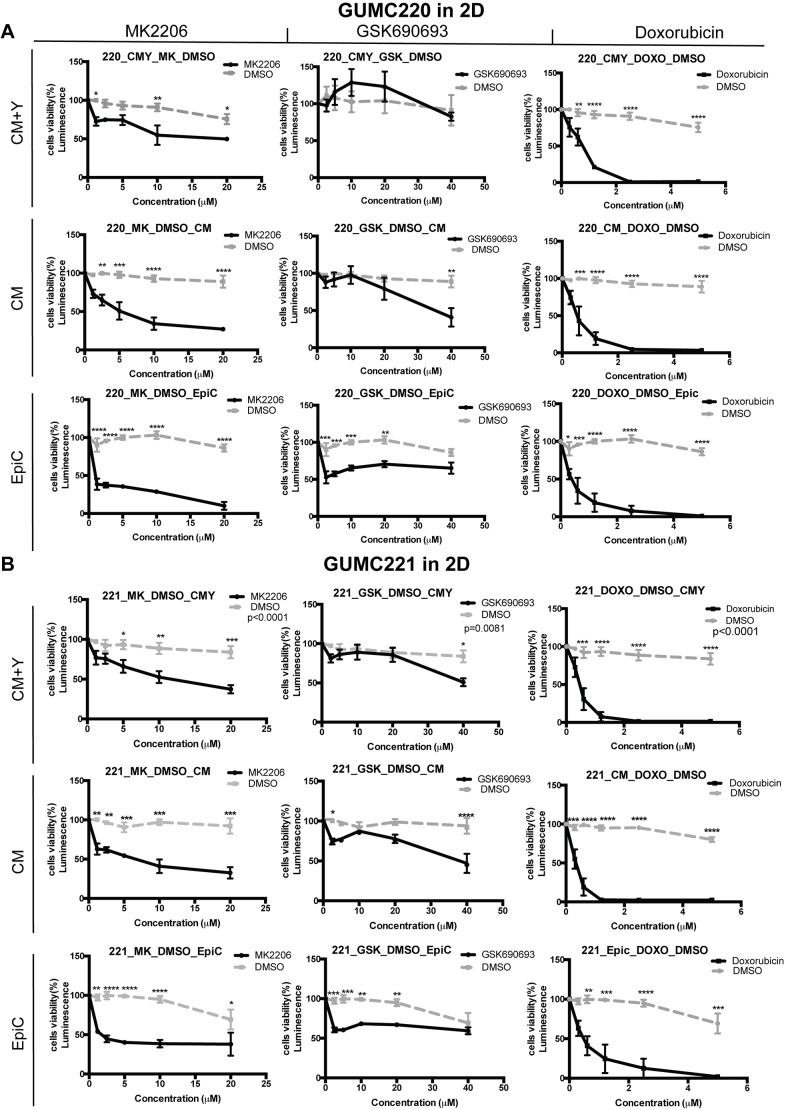
Viability of GUMC220/221 2D cell cultures exposed to MK2206, GSK690639 and doxorubicin in CM+Y, CM and EpiC media. (A,B) Cell viability measured after 3 days for GUMC220 (A) and GUMC221 (B) in three different 2D culture media (CM+Y, CM and EpiC), at a range of concentrations in the presence of MK2206 (1.2-20 μM, solid black line) compared to DMSO (vehicle control, dashed gray line) (left column), GSK690639 (2.5-40 μM, solid black line) compared to DMSO (vehicle control, dashed gray line) (middle column), and doxorubicin (0.3-5 μM, solid black line) compared to DMSO (vehicle control, dashed gray line) (right column). Data are mean±s.e.m. One DMSO vehicle control was used for each medium each time an experiment was performed (dashed gray line). Each experiment included three technical replicates, and each experiment was performed three times. *P≤0.05, **P≤0.01, ***P≤0.001, ****P≤0.0001, one-tailed, one-way ANOVA.